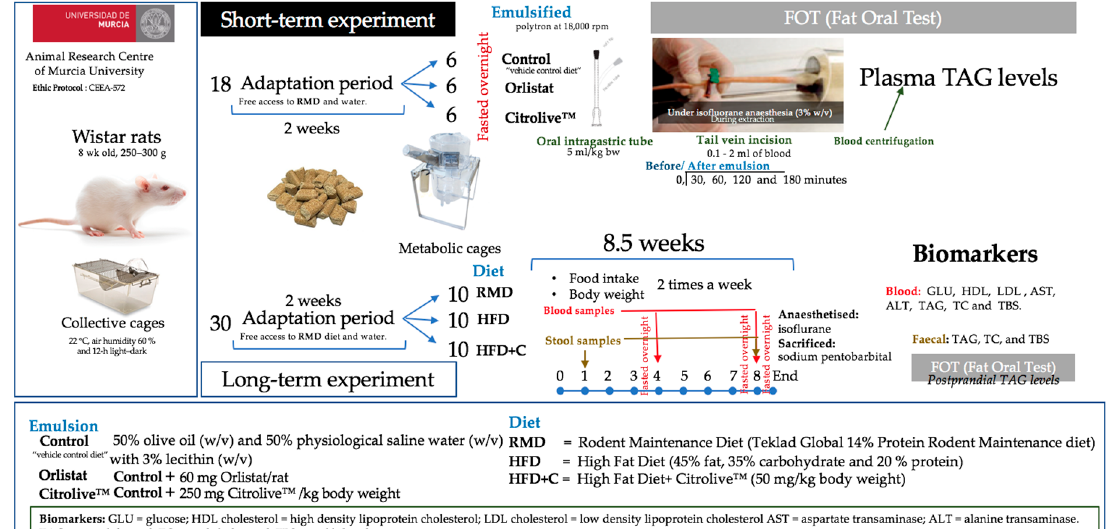
Figure 1. Study design of short- and long-term experiments to evaluate the effect of the consumption of citrus fruit and olive leaf extract on lipid metabolism.